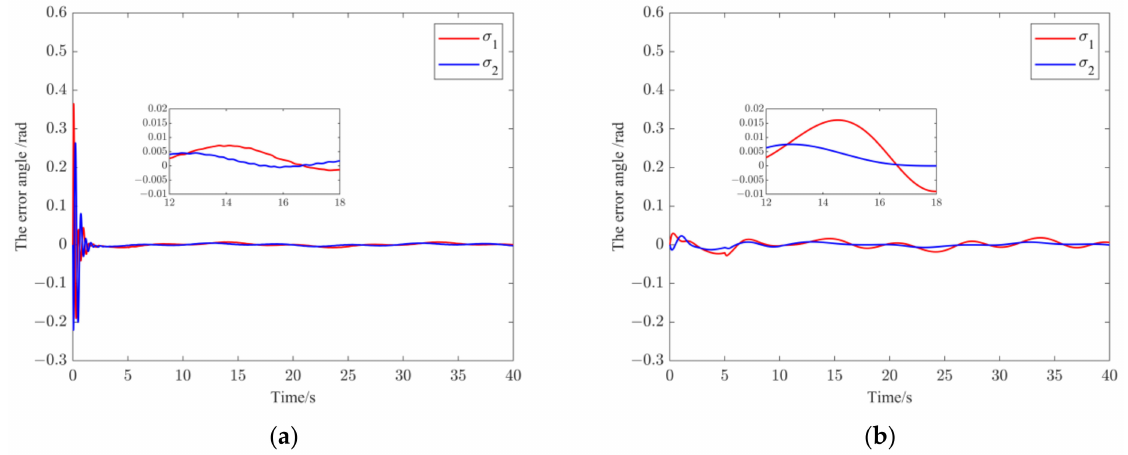
Figure 22. The angle error σ . ( a ) RBFTHC, ( b ) CTC.